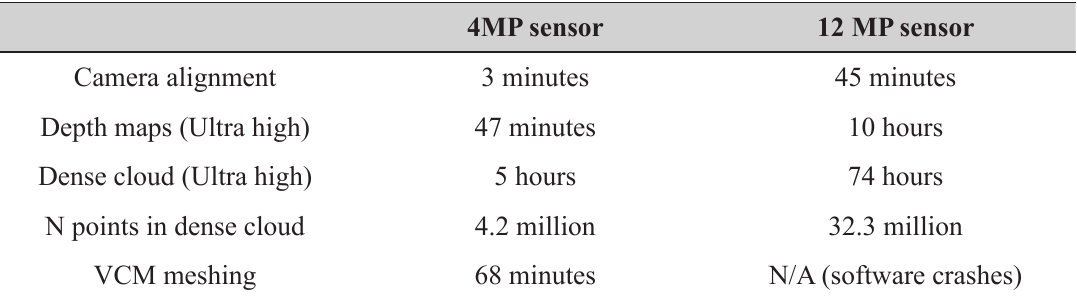
Table 3.3. DISC3D camera comparison for processing 398 2D+ images for model generation in Agisoft Photoscan Pro 1.4.5 (build